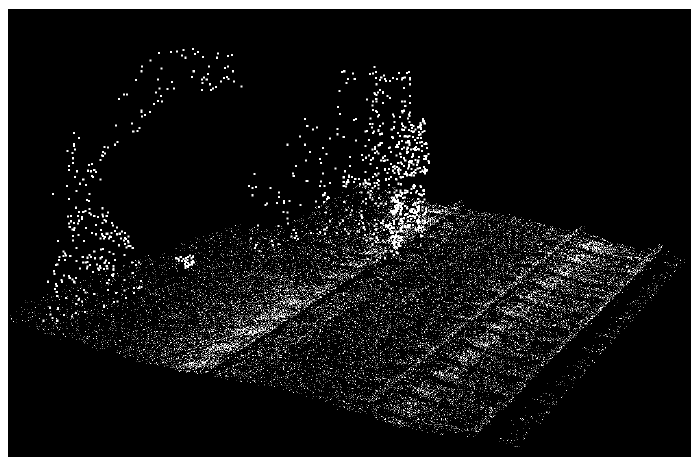
Figure 14. An external object on the rail tracks prevented the complete data collection on some parts of the rail tracks.